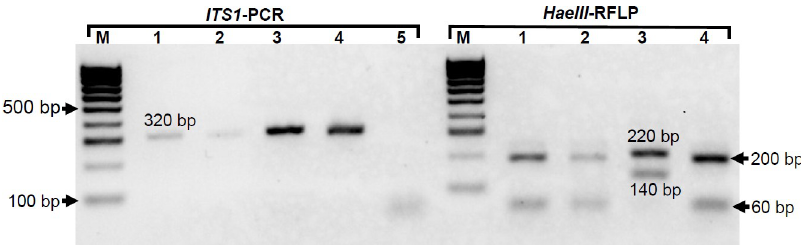
Fig 4. Leishmania parasite identification by ITS1 -PCR-RFLP. M: 100 bp ladder;1 and 2: Leishmania spp. isolated from sandflies; 3 and 4: L . major (Friedlin strain) and L . tropica (Lv357 strain) positive controls; 5: negative control. Molecular sizes of RFLP product for each species are shown; L . major (220 and 140 bp); L . tropica (200 and 60